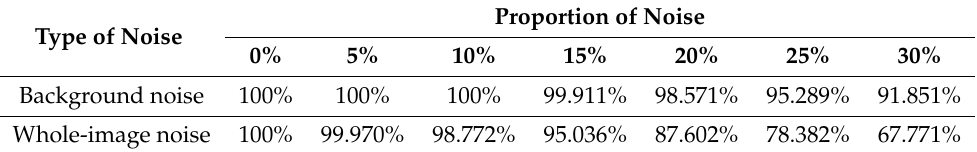
Figure 18. Computer simulation results of orientation detection on an object with 135 ◦ orientation angle. ( a ) Object and image noise. ( b ) Spike records. ( c ) Spike rate curve of four types of complex cells. Table 2. The recognition accuracy of AVS under two noise